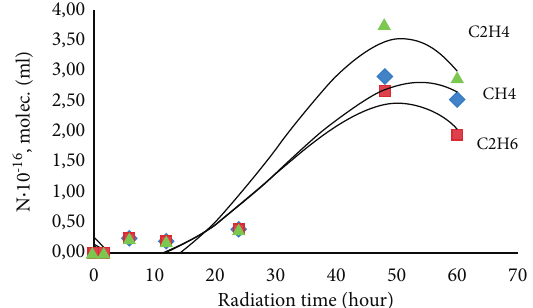
Figure 2: Kinetic dependence of methane, ethane, and ethylene from radiolysis of hexane and nano-Al 2 O 3 systems (20nm